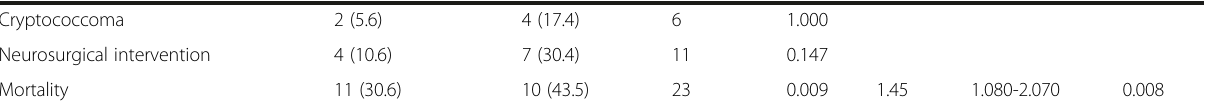
Table 3 Comparison of clinical features, laboratory findings, and outcomes between delayed and non-delayed groups of CM patients